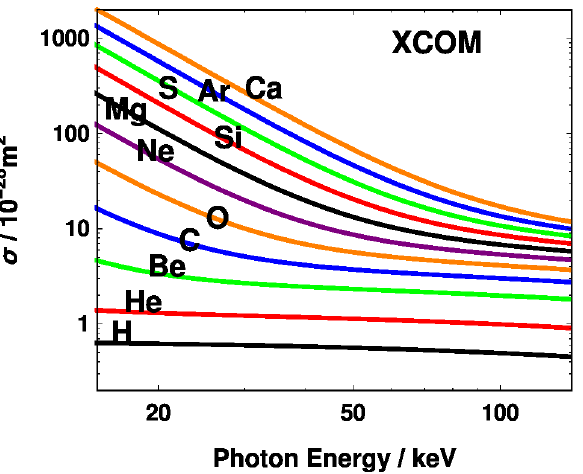
Fig 1. Cross sections for the first 20 chemical elements from XCOM, [7] with curves shown only for hydrogen and even atomic numbers.